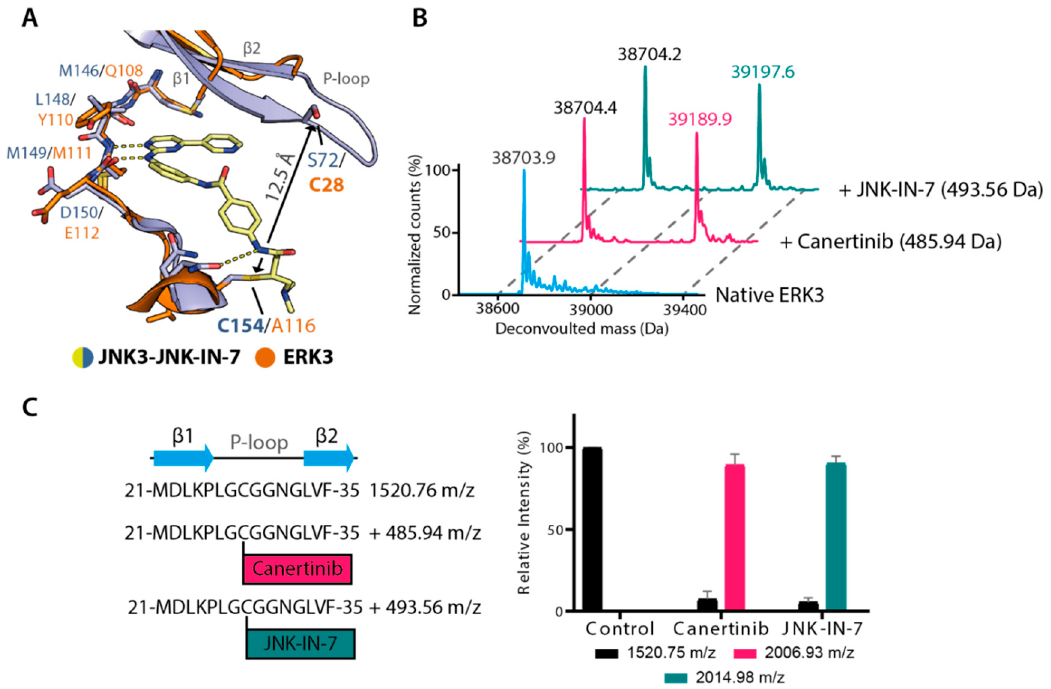
Figure 3. Irreversible binding of canertinib and JNK-IN-7 in ERK3. ( A ) Superimposition of the JNK3-JNK-IN-7 complex and ERK3 structure. ( B ) Intact mass analyses indicate covalent adducts between ERK3 and canertinib or JNK-IN-7. The counts of the highest peaks in each spectrum were normalized to 100%. ( C ) Mass spectrometry analyses of the peptides after chymotrypsin digestion of ERK3, which was pre-incubated with canertinib or JNK-IN-7 for 3 h. Left: the sequence of the digested peptide that covers the glycine rich loop region harbouring C28. The m / z shifts of + 485.94 and + 493.56 suggest C28 residue in this peptide is the target for covalent bonding with canertinib and JNK-IN-7, respectively. Right: relative intensity of the peptides from mass-spectrometry analysis.